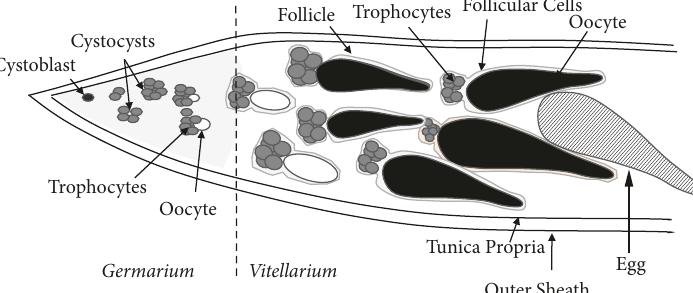
Figure 1: Schematic representation of the ovariole of Therophilus javanus showing differentiated oocyte and accompanying nurse cells (trophocytes) within the ovariole. Immature eggs recorded in our enumeration are large individual egg chambers (follicle) located in the vitellarium whose oocyte displayed an ovoid form and had a slender tapering stalk at their posterior end in solid black color, and mature eggs recorded are large individual egg chambers (egg) of ovoid form that had a slender tapering stalk at their posterior end in black striped color.